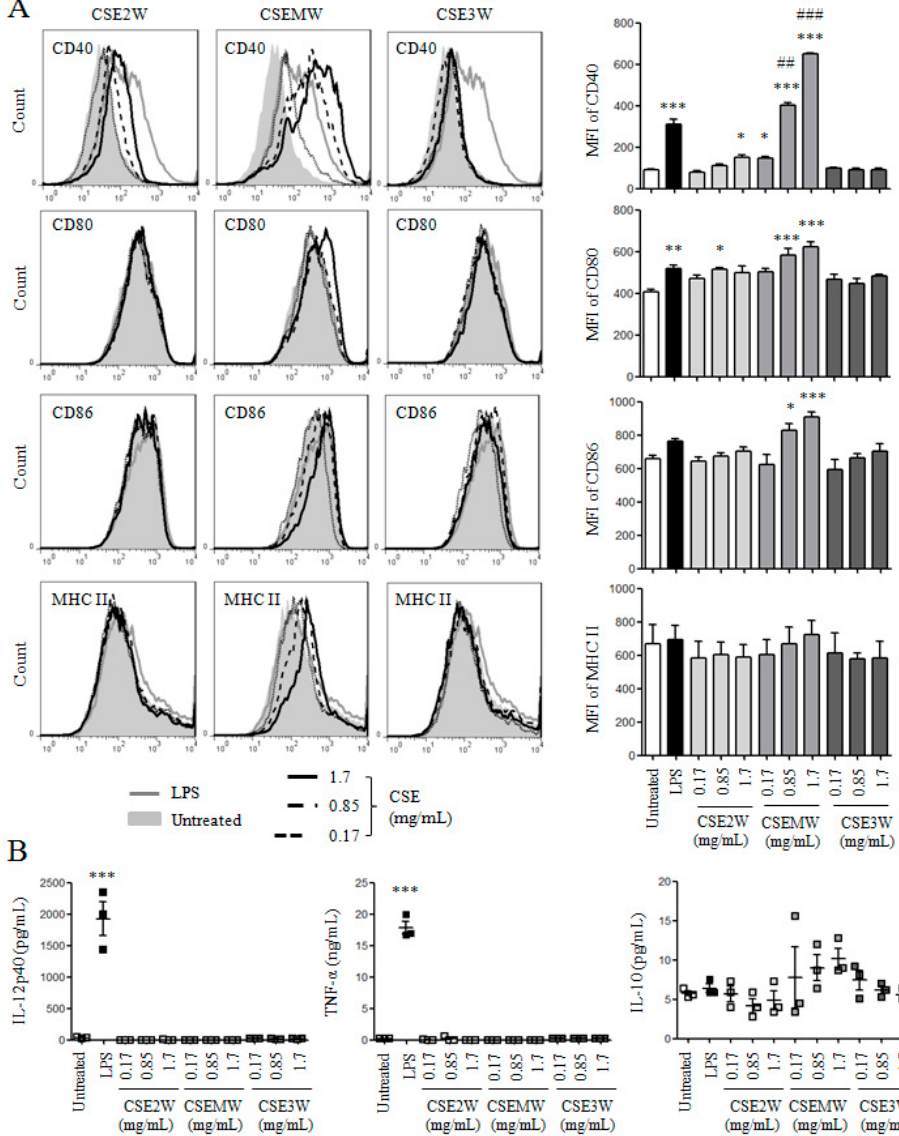
Figure 3. The effect of polysaccharides in CSE2W, CSEMW, and CSE3W on DC maturation. DCs were treated with different concentrations of polysaccharides in CSE2W, CSEMW, and CSE3W for 12 h. ( A ) Cells were collected to analyze the expressions of CD40, CD80, CD86, and MHC II by flow cytometry. MFI of these molecules is shown; ( B ) The supernatants were collected to detect the secretions of IL-12p40, IL-10, and TNF- α by ELISA. The concentrations of IL-12p40, IL-10, and TNF- α are shown. Data are from four independent experiments and analyzed by ANOVA. * p < 0.05; ** p < 0.01; *** p < 0.001 compared to untreated DCs. ## p < 0.01; ### p < 0.001 compared to LPS treated DCs.